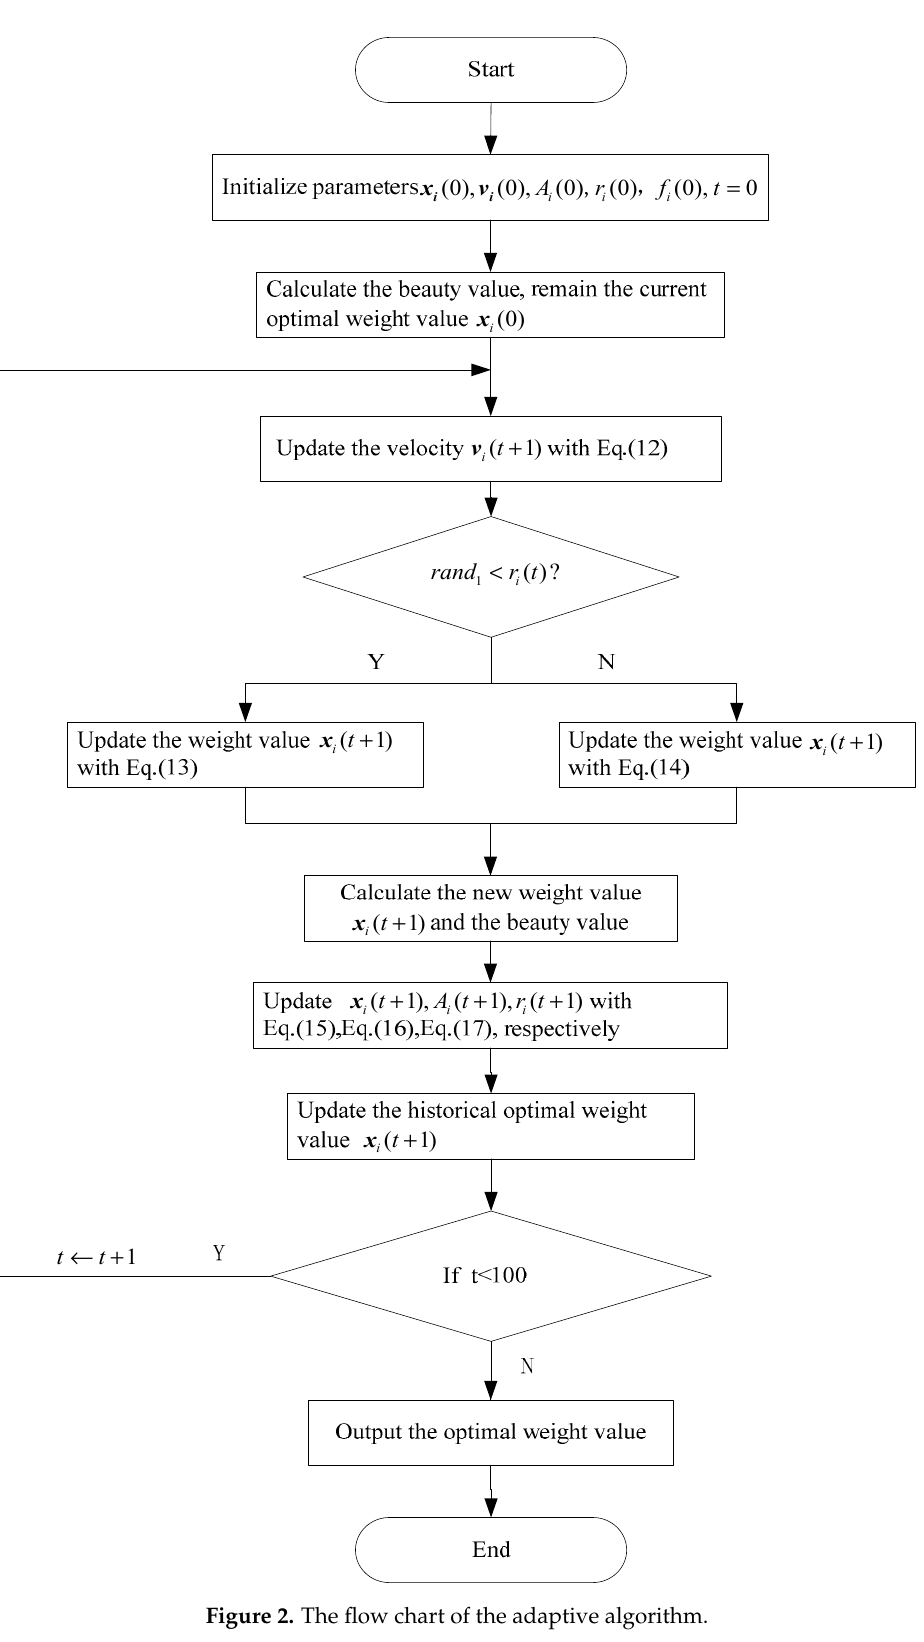
Figure 2. The flow chart of the adaptive algorithm.